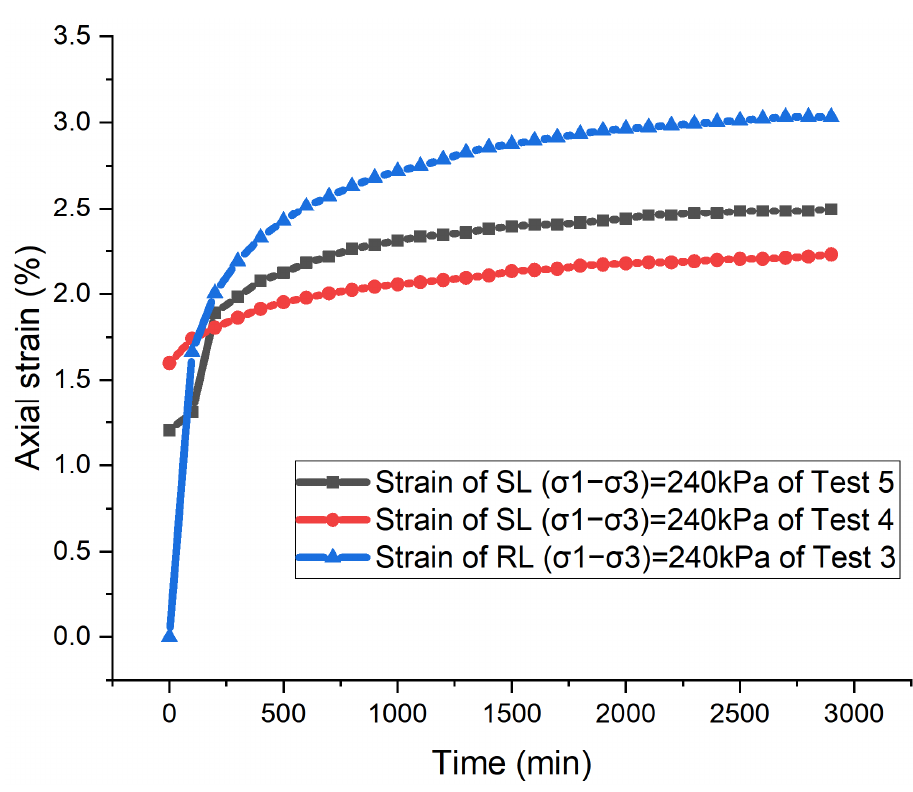
Figure 8. Comparison of axial strain tested in different loading modes when ( σ 1 − σ 3 ) = 240 kPa (Test 3, 4, 5).